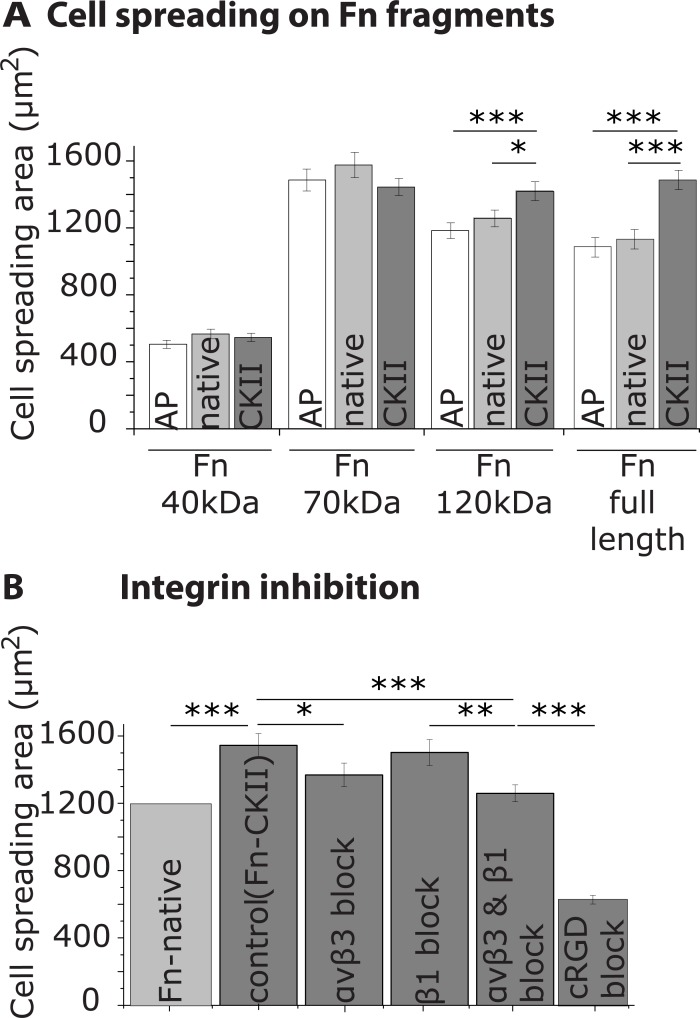
Relative contributions of fibronectin fragments and of integrin inhibitors to the upregulated cell spreading on phosphorylated fibronectin on flat substrates.A: Cell spreading assay on fibronectin (Fn) fragments as defined in Fig 2. B: Inhibition of αvβ3 and α5β1 integrins on CKII-treated fibronectin. Fibroblasts were preincubated for 10 min with 2.5μg/ml integrin isoform-specific anti-αvβ3 antibodies, anti-α5 antibodies, or 10μg/ml cyclic RGD. Cell spreading area of single cells was measured 30 min after seeding. Statistical comparison done with Student’s t-test between pair of samples connected with lines on the column plots: ***, p-value<0.005; **, p-value<0.01; *, p-value<0.05; not significant (ns).